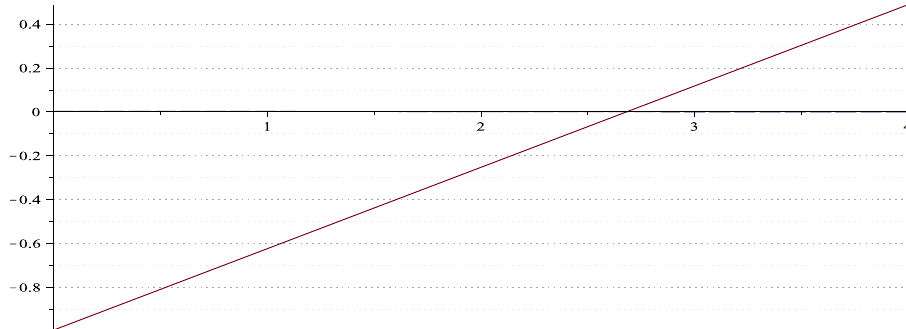
Figure 2. u ∗ ( t ) and v ∗ ( t )